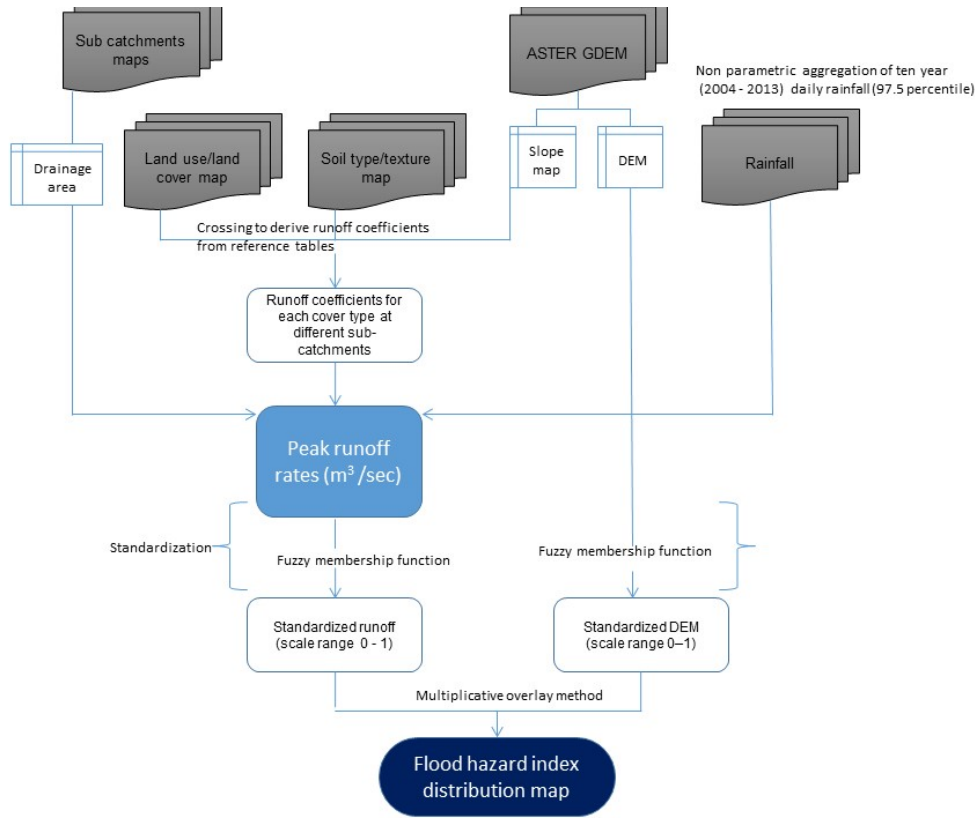
Figure 4. Integration of hydrological and statistical models with